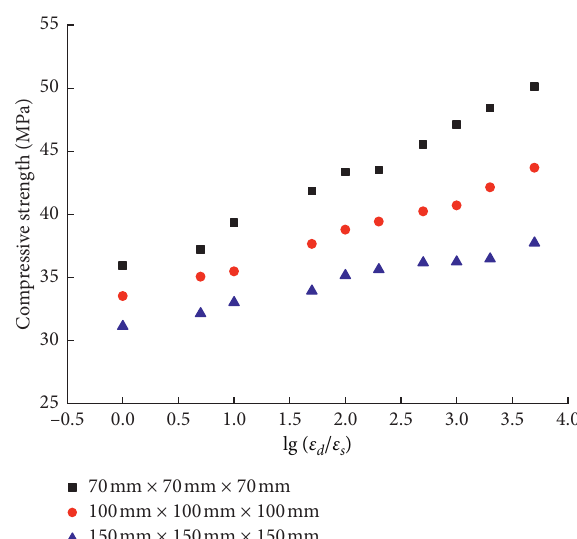
Figure 7: Relationship between loading strain rate and com- pressive